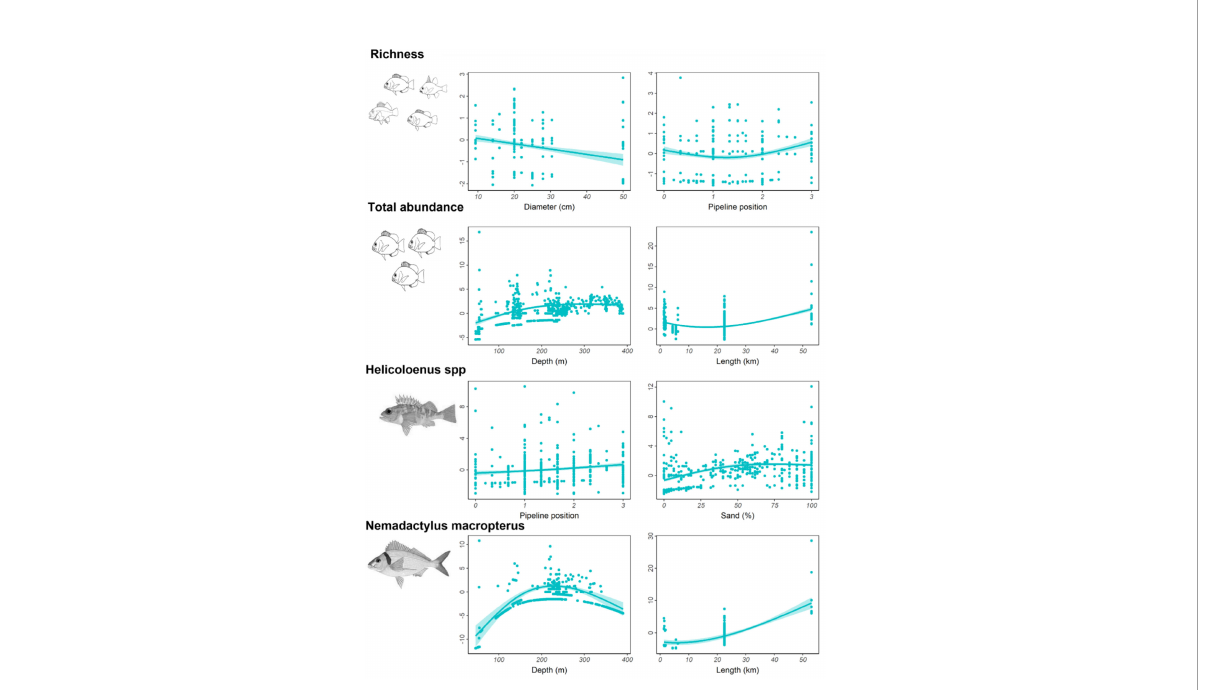
FIGURE 10 Total residual abundance of fi shery target species, richness and residual abundance of the two most common fi shery target species on pipelines in<400 m depth in the south-east. Residual abundances are plotted relative to their most important explanatory variables (Table 8, Figure S5). Models were fi tted using Generalised additive models. The solid line represents the estimated smoothing curve, and dashed lines represent ±2 × south-east of the estimate.